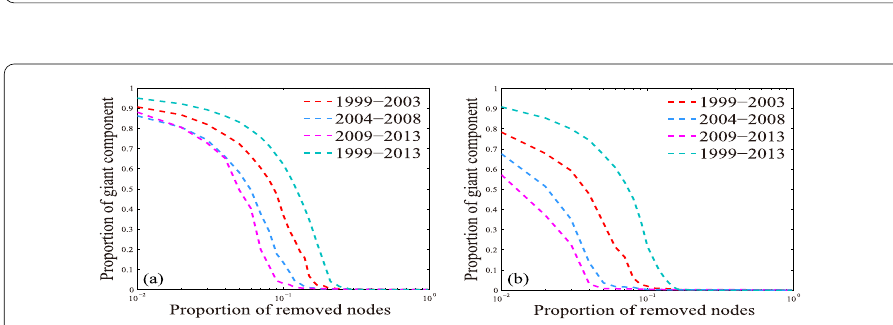
Figure 8 The relationship between giant component size and degree/hyperdegree. Nodes are removed from high degree/hyperdegree to low respectively. For degree and hyperdegree respectively, the relation curves between the proportion of removed nodes and that of the giant component show that a considerable number of authors contribute to the formation of giant component. The left-shifting trend of the